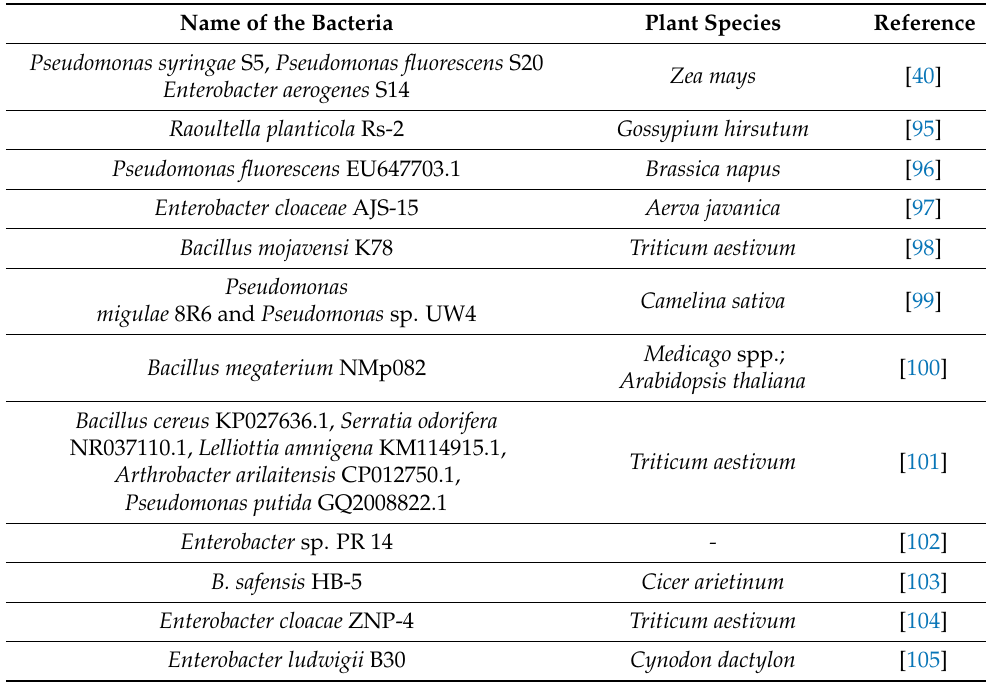
Table 2. ACC deaminase-producing salt-tolerant bacteria. Name of the